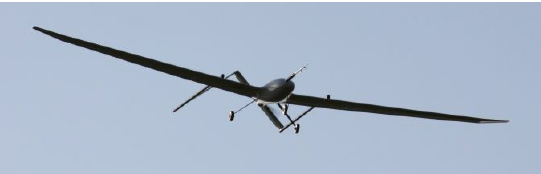
Figure 1: The UAS ZHAW-UMARS with 5 m wing-span and up to 10 kg payload.